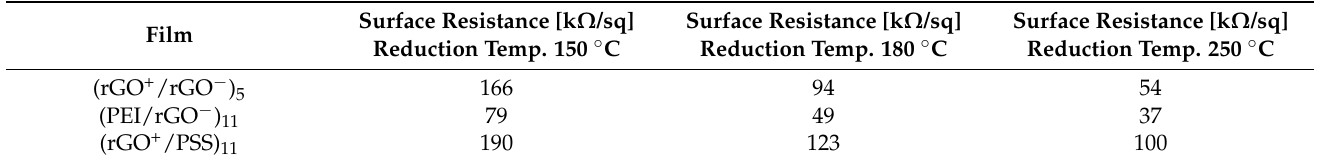
Table 3. The comparison of the surface resistance values for the multilayer films deposited on quartz plates, containing the comparable number of the rGO layers, i.e., (rGO + /rGO − ) 5 , (PEI/rGO − ) 11 , and (rGO + /PSS) 11